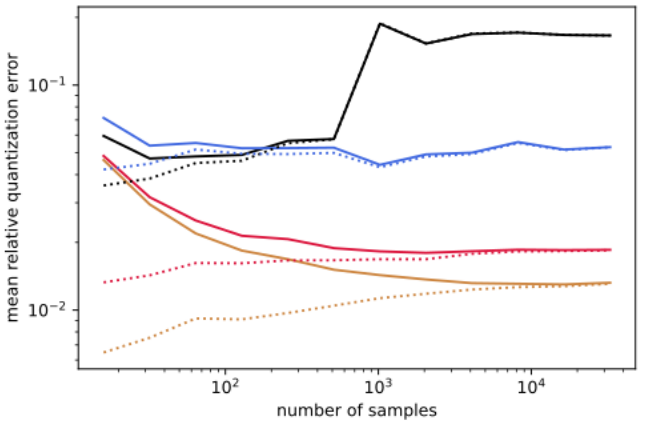
32 SOM × 64 86 SOM classification trained by North × ×